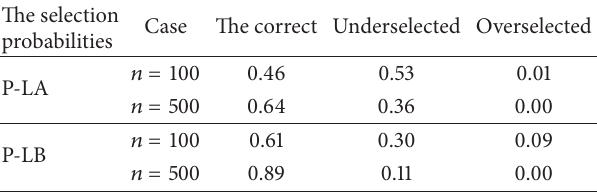
Table 1: The selection probabilities of adaptive EL shrinkage estimation.